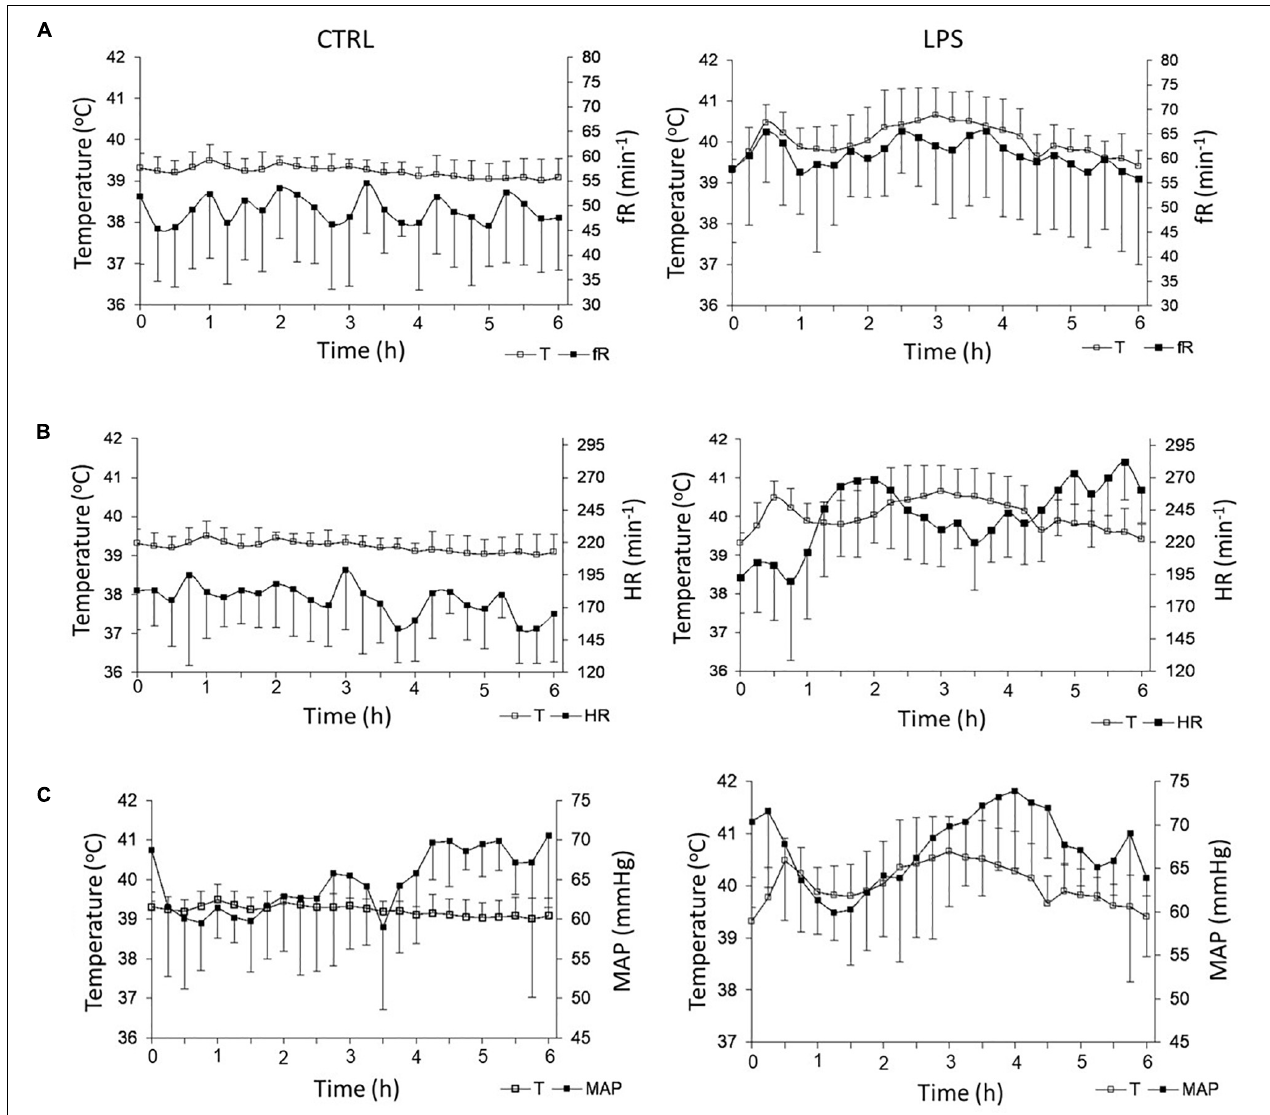
FIGURE 3 | Effects of lipopolysaccharide injection on heart rate and respiratory frequency. LPS injection significantly increased respiratory frequency (A) and heart rate (B) compared to control condition. No significant alteration was observed for mean systemic arterial pressure (C) . Left panel: control condition (CTRL); right panel: LPS condition. f R , respiratory frequency; T, temperature; HR, heart rate; and MAP, mean arterial pressure. Results are illustrated as mean ±